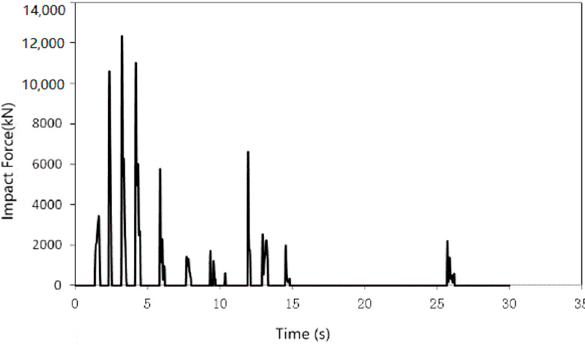
Figure 12. Time-history curve of impact force for model B.